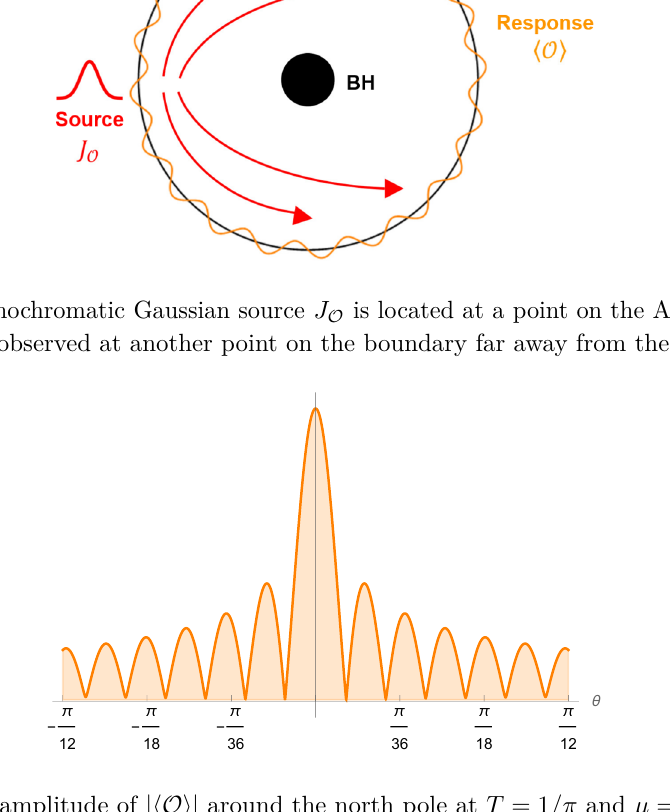
. In addition, it follows from eq. (2.3) l